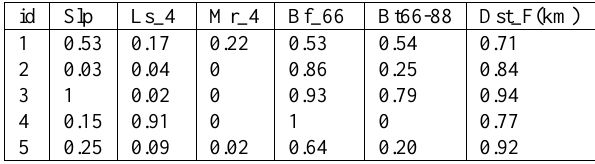
Table 4. Normalized attribute values of five randomly selected statistical